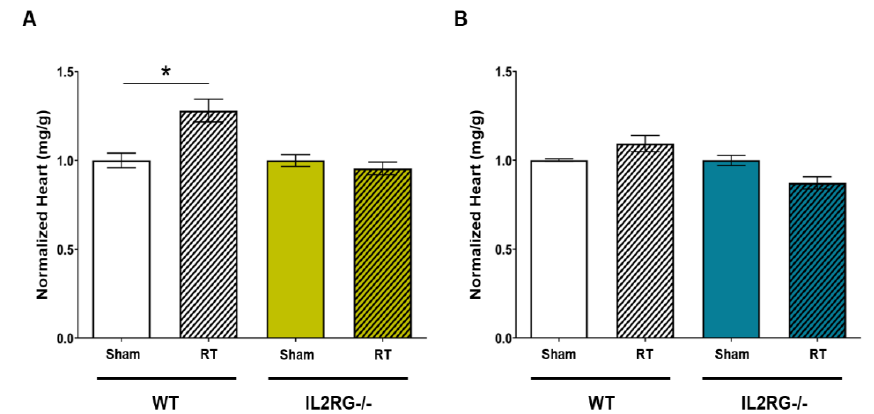
Figure 4. Immune-competent SS WT female rats exhibit cardiac hypertrophy after cardiac radiation, but no hypertrophy occurs in female SS IL2RG −/− rats or in male WT or IL2RG −/− rats. Heart-to-body-weight ratios were measured at harvest in adult SS WT immune-competent and SS IL2RG −/− ( A ) female and ( B ) male rats that were given either sham or 24 Gy RT. At five months, hypertrophy was evident in the female immune-competent SS WT rats that received RT versus sham treatment. At six months, cardiac hypertrophy did not occur in the SS IL2RG −/− female rats. Male rats did not display hypertrophy after 24 Gy ( B ). Values were normalized to the sham-treated animal group average and are the means ± SEM. n = 8–15 rats/radiation group and 4–6 rats/control group; * p < 0.05.